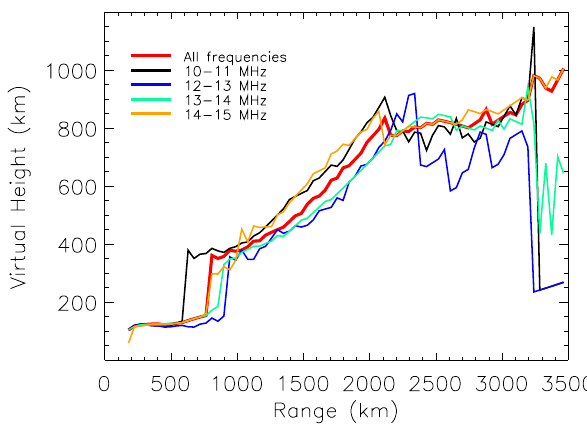
Fig. 9. Peak virtual height variations determined for each frequency range. The black, blue, green, and yellow curves show the vari- ations for frequency ranges 10–11MHz, 12–13MHz, 13–14MHz, and 14–15MHz, respectively. The red curve shows the peak vir- tual height variation determined when using the whole data set (all frequencies) as shown in Fig. 7.